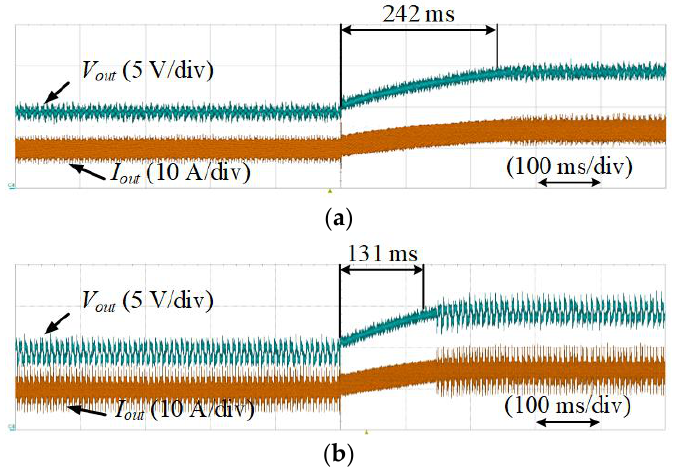
Figure 15. Experimental results of the PSFB-CT converter using the SMC depending on K SMC . ( a ) K SMC = 1; ( b ) K SMC = 3.